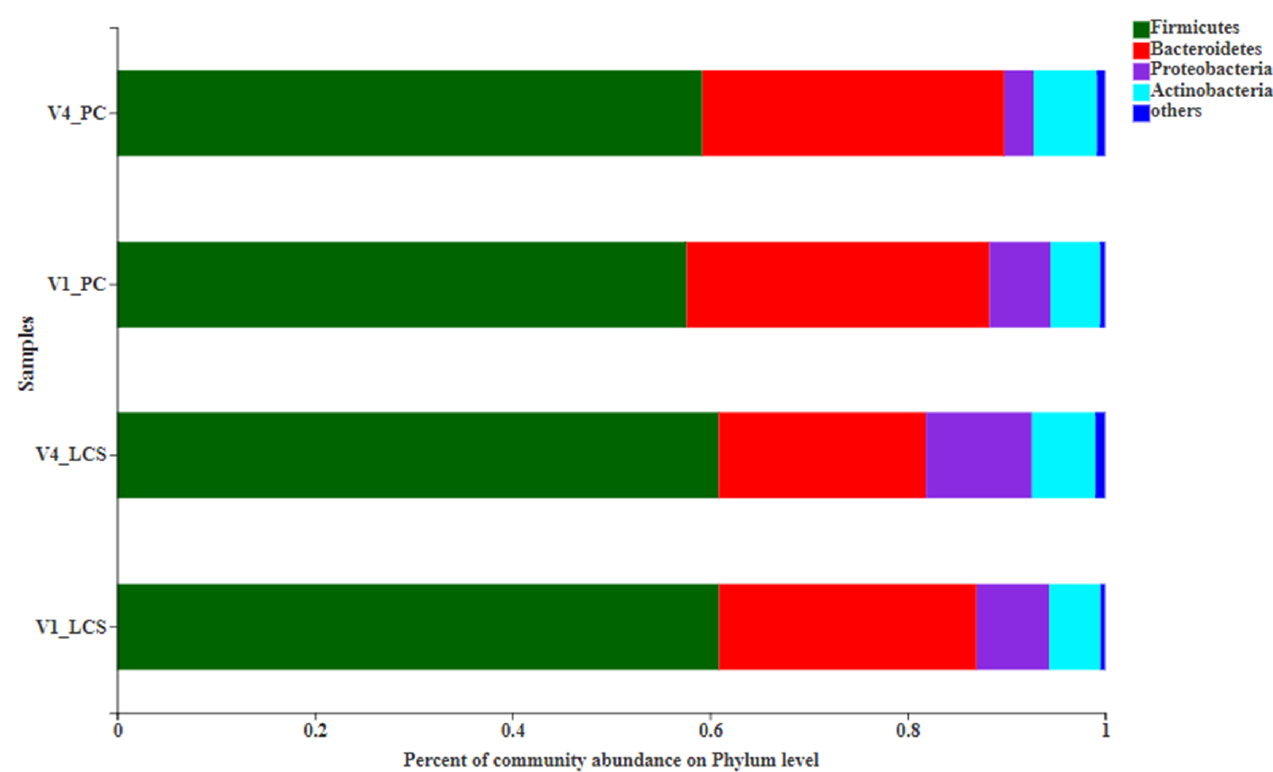
Figure 4. Relative abundance of main phyla in different groups. V1_LCS: samples at V1 in the LcS group, V4_LCS: samples at V4 in the LcS group, V1_PC: samples at V1 in the placebo group, and V4_PC: samples at V4 in the placebo group.